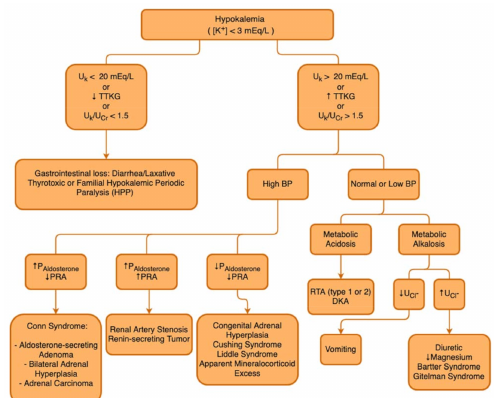
Figure 3. Hypokalemia diagnostic flowchart. UK : Urinary Potassium; TTKG: Transtubular Potassium Gradient; UCr : Urinary Creatinine; BP: Blood Pressure; DKA: Diabetic Ketoacidocis; PAldosterone : Plasmatic Aldosterone; PRA: Plasmatic Renin Activity; RTA: Renal Tubular Acidosis; UCl − : Uri- nary